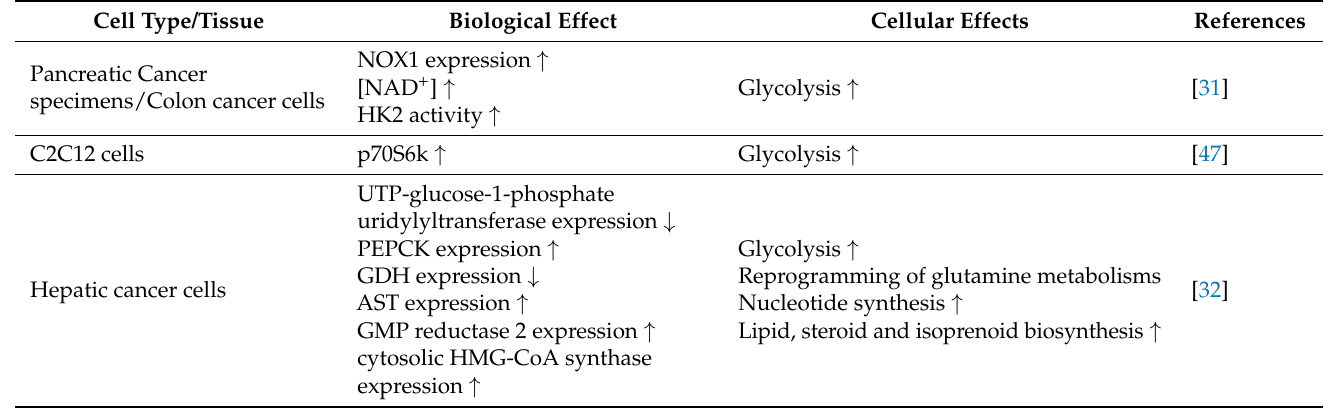
Table 1. NOX1 implication in cell metabolism regulation.